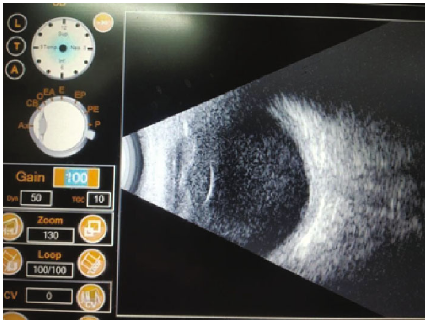
Figure 6: Slit lamp view of the left eye showing relieve of iris bombe after synechiolysis but presence of postoperative in fl ammatory reactions in the anterior